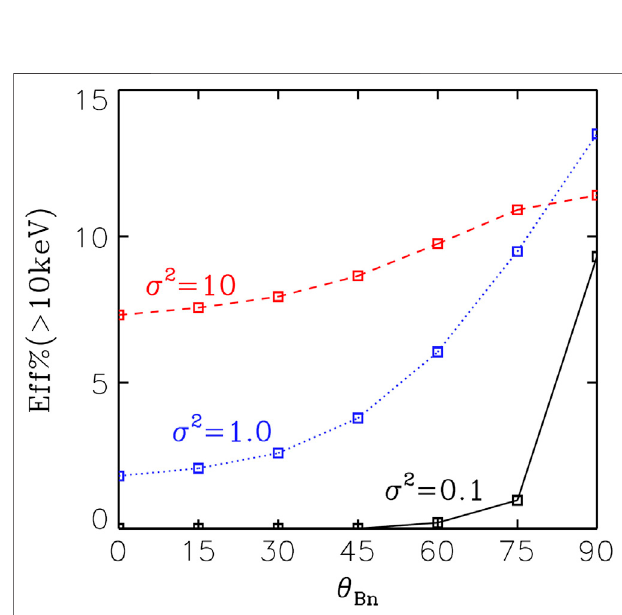
FIGURE 7 | Ef fi ency of electron acceleration for various wave variances as a function of shock angle. The ef fi ciency is de fi ned by the fraction of electrons that is accelerated to more than 10 keV at the end of test-particle simulations (adapted from Guo and Giacalone (2015). Reproduced by permission of the